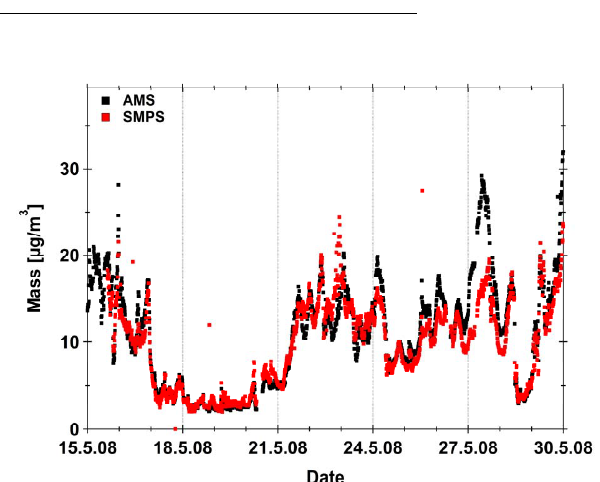
Fig. 4. Time series of AMS total mass and mass derived from SMPS Figure 4: Time series of AMS total mass and mass derived from SMPS measurements in 3 measurements in 2008. 2008.4